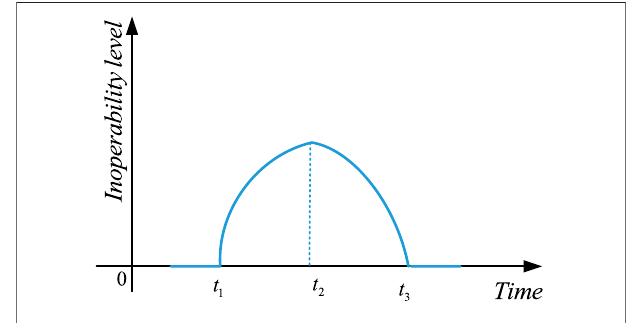
FIGURE 1 | Power grid elastic description based on the inoperability model.